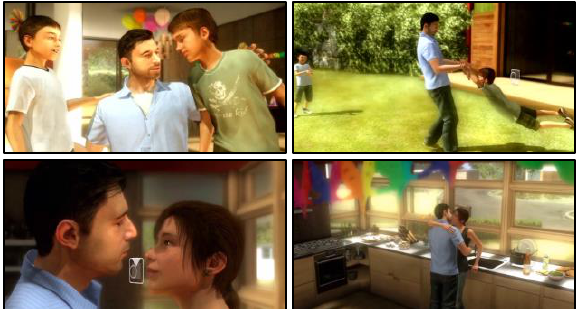
Figure 2 | ‘Attachment’ expressed by touching actions. Pictures extracted from the ‘Chapter 1: Prologue’ of Heavy Rain